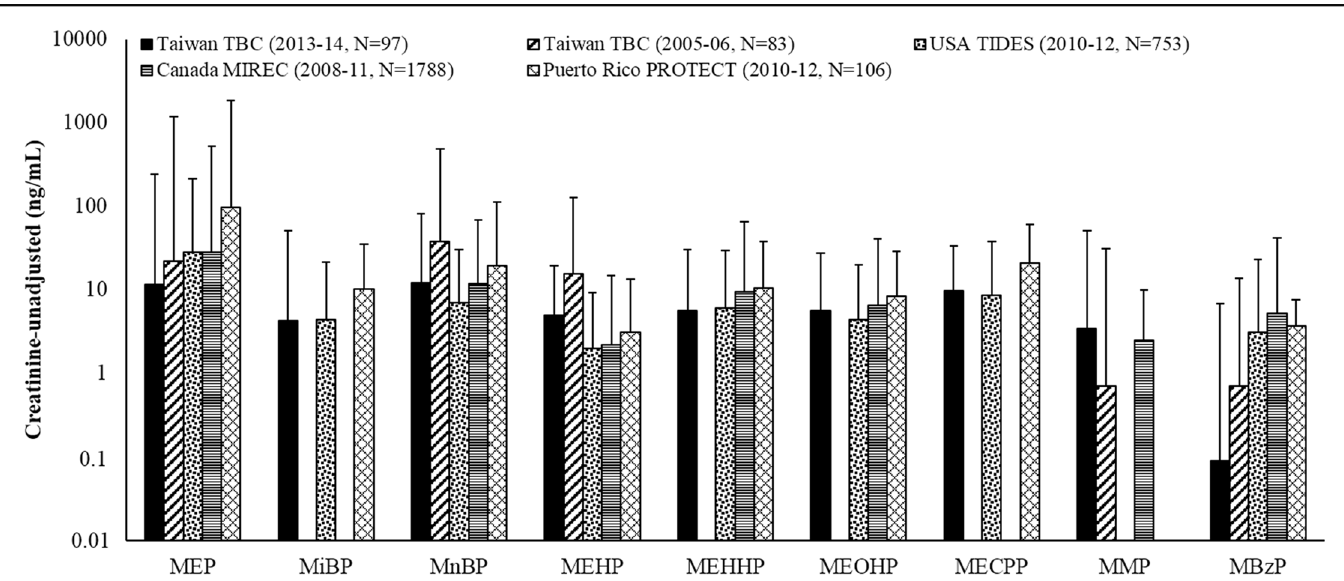
Fig 1. Comparison of urinary phthalate metabolites (ng/mL) at the first trimester in pregnant women in Taiwan, Unite States, Canada and Puerto Rico. TBC: Tainan Birth Cohort; TIDES: The Infant Development and the Environment Study; MIREC: Maternal-Infant Research on Environmental Chemicals; PROTECT: Puerto Rico Testsite for Exploring Contamination Threats.